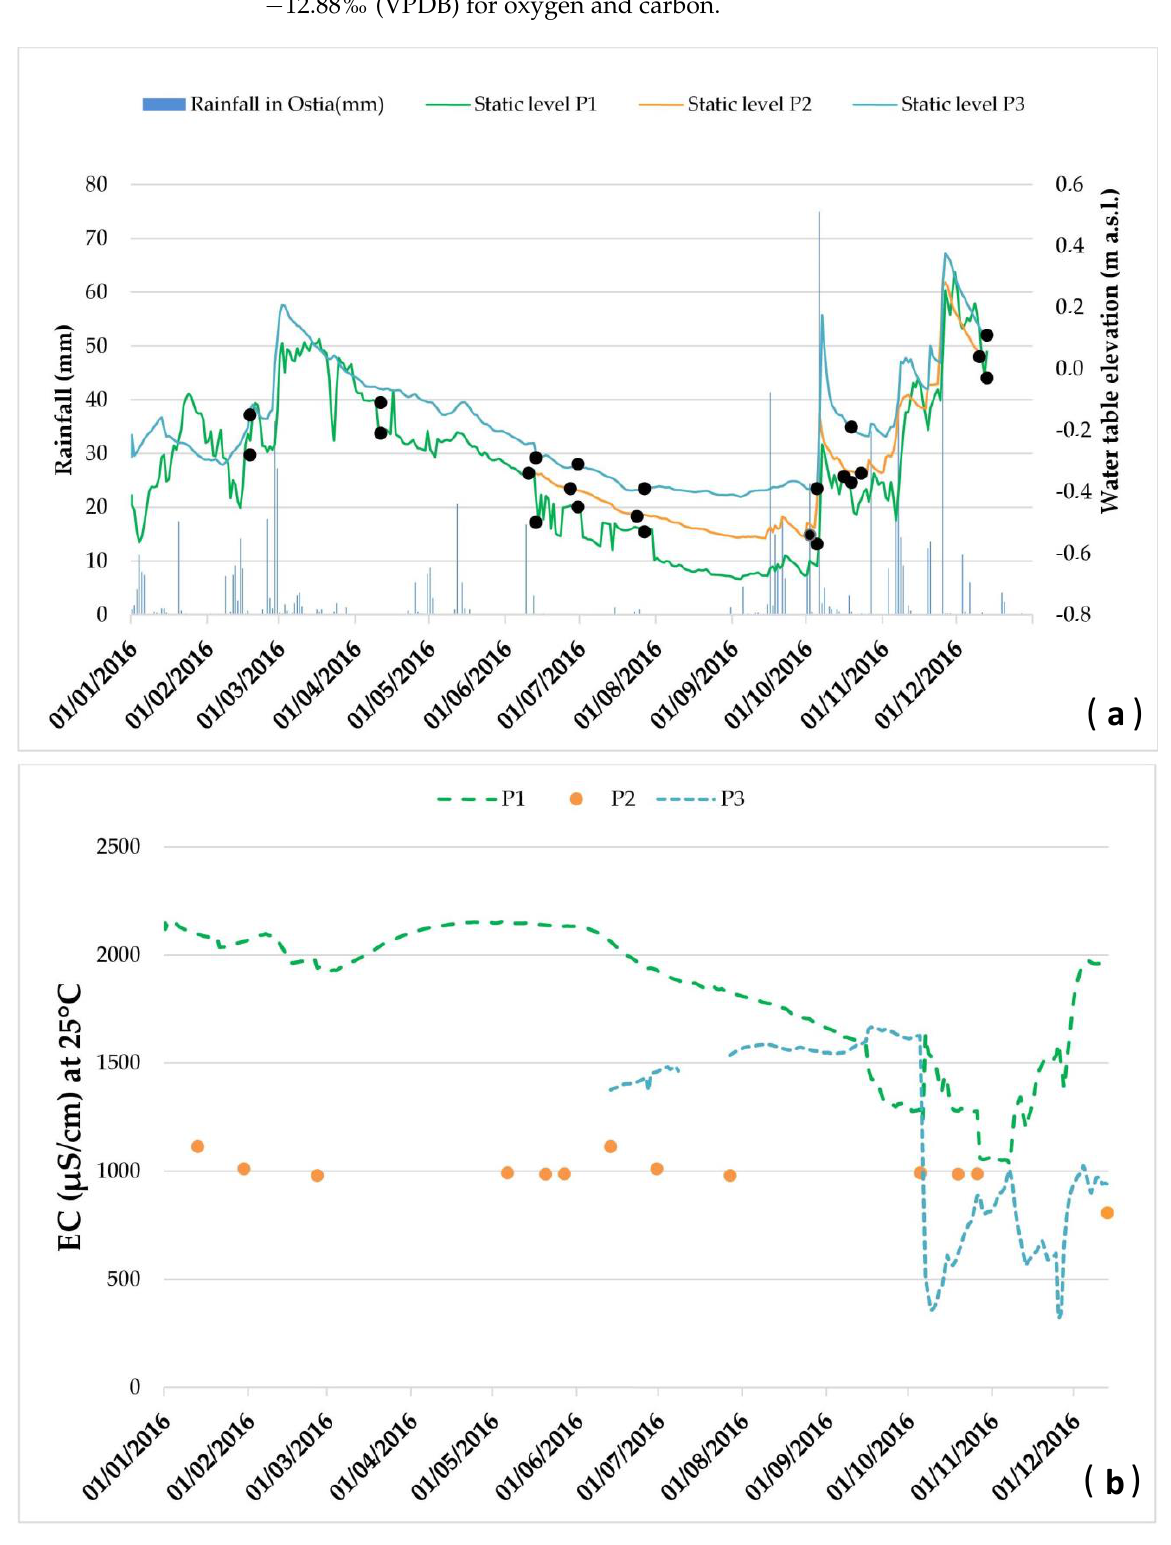
Figure 4. ( a ) Rainfall amount and water table level recorded at wells P1, P2, and P3 during the year 2016. Manual water level measurements (black dots) are superimposed on the continuous water level recorded at wells P1, P2, and P3. ( b ) Electrical conductivity (EC) of wells P1, P2 (discontinuous manual measurements), and P3 during the year 2016.